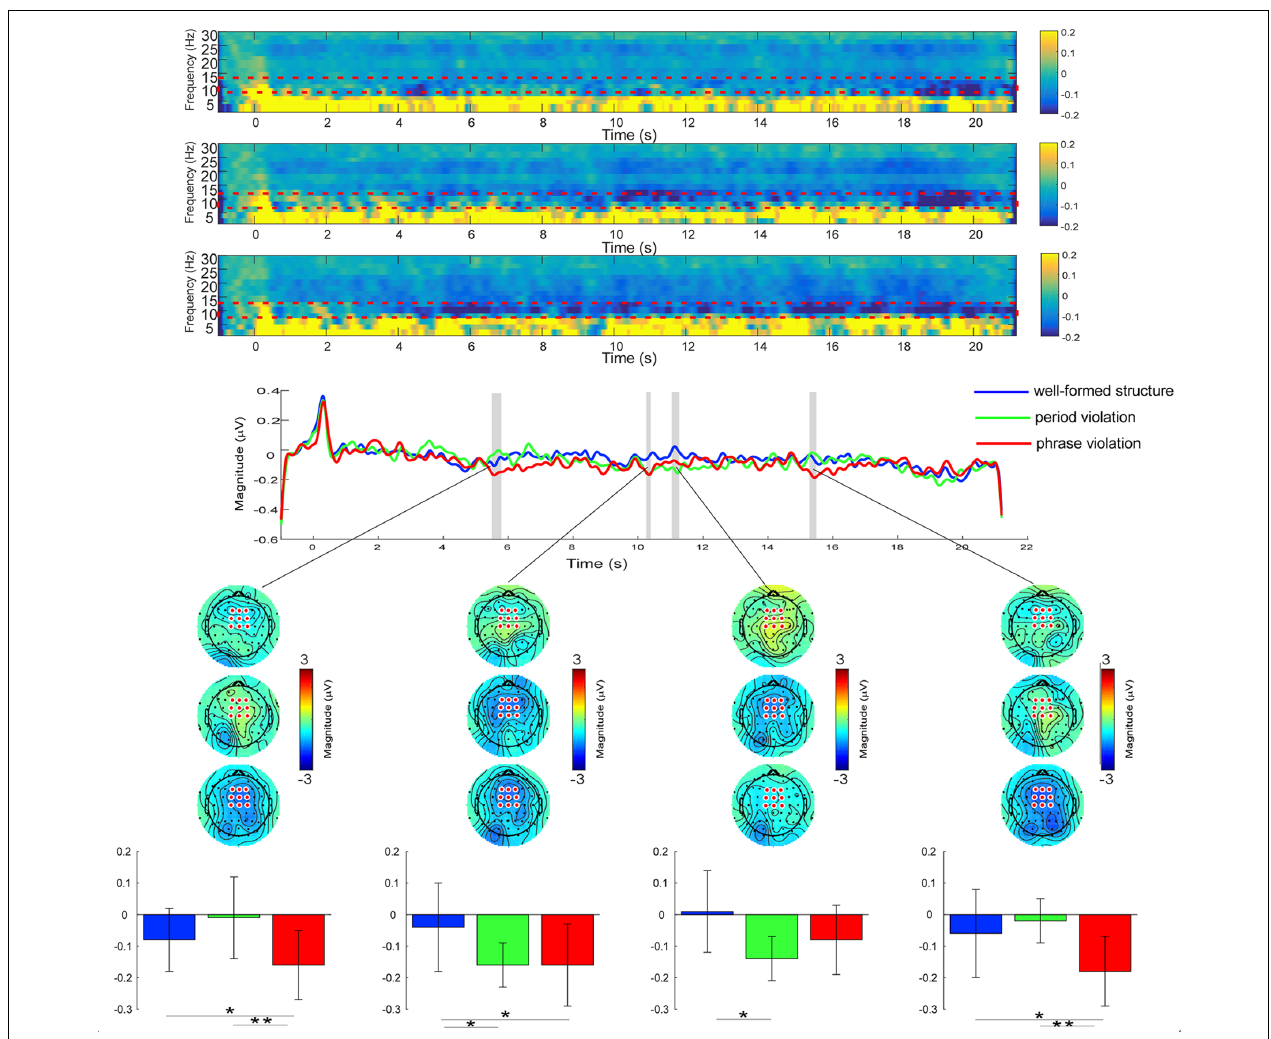
FIGURE 4 | Top : the time-frequency analysis of electroencephalographic series in the three conditions at the FCz electrode. Alpha band frequencies (8–13 Hz) were selected as the regions of interest (ROI). The color scale represents the average decrease or increase of oscillation power. Middle : the alpha power at frontal-central electrodes during the whole music sequences. Significant regions are marked in the gray bar ( p < 0.05, one-way ANOVA test, and FDR-corrected). Bottom : the scalp topography of the alpha band power for the three conditions within the significant time-window of 5,536–5,808 ms (736–1,008 ms after the onset of the second phrase), 10,284–10,432 ms (684–832 ms after the onset of the third phrase), 11,100–11,332 ms (1,500–1,732 ms after the onset of the third phrase), and 15,300–15,532 ms (900–1,132 ms after the onset of the last phrase). Colored bars represent the mean of alpha power in the three conditions for each time window (expressed as mean ± SD). * p < 0.05; ** p <